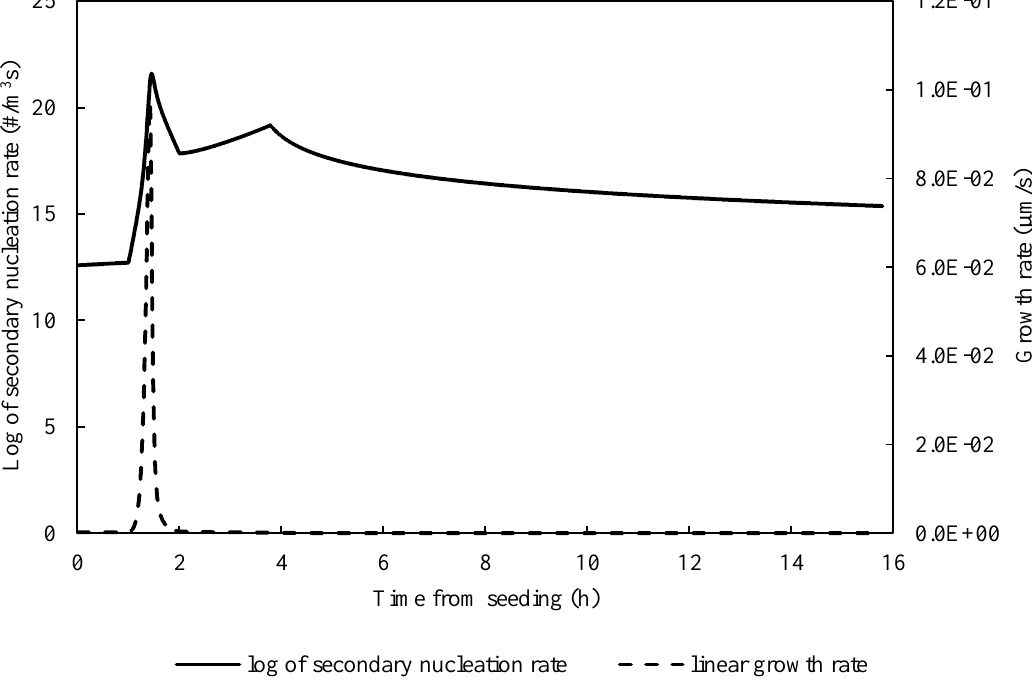
Figure 2. Simulated growth and secondary nucleation rates throughout a crystallization process of BMS compound A.